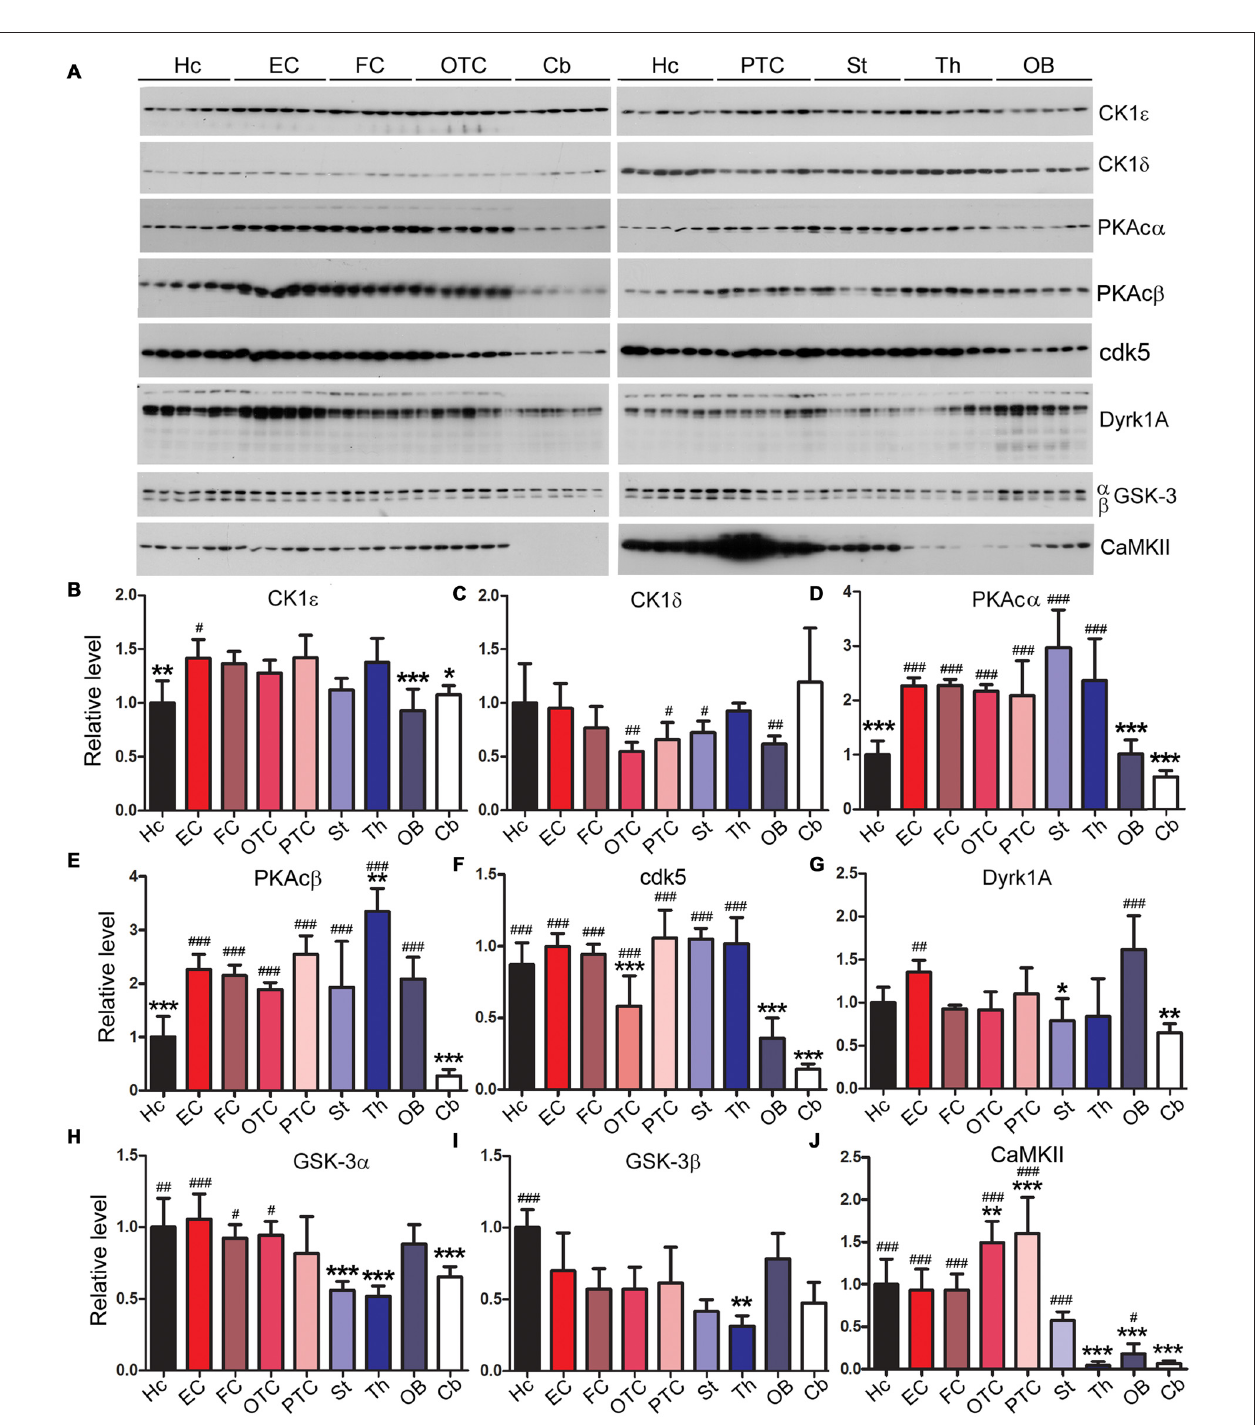
FIGURE 6 | Expressions of tau kinases differ in various rat brain regions. Western blots (A) were used to examine relative levels of tau kinases, CK1 ε (B) , CK1 δ (C) , PKAc α (D) , PKAc β (E) , cdk5 (F) , Dyrk1A (G) , GSK-3 α (H) , GSK-3 β (I) and CaMKII (J) . Data are expressed as mean ± SD, which represents matched observations of individual brain regions in six rats. ∗ Compared to EC; # compared to cerebellum. ∗ , # P < 0.05; ∗∗ , ## P < 0.01; ∗∗∗ , ### P < 0.001.